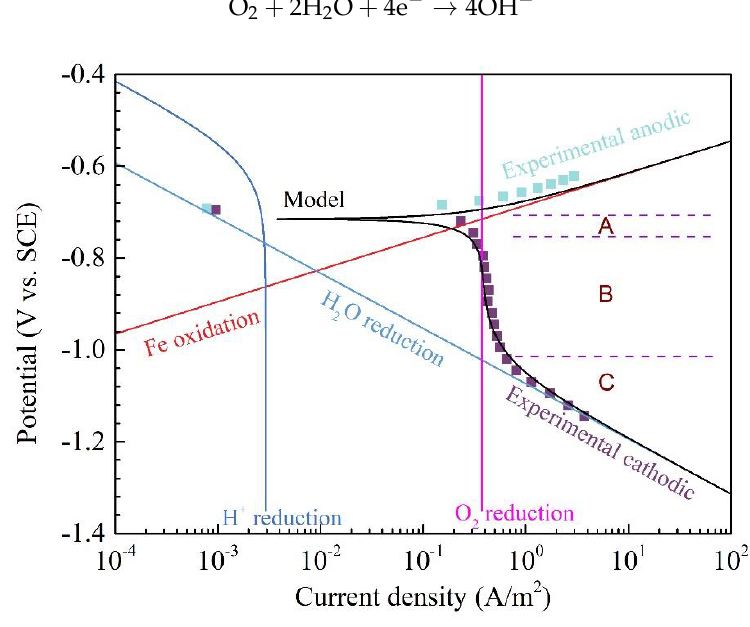
Figure 2. The polarization curves and its modeling results of Q345R steel in 1 wt.% NaCl solution containing 4.16 mg/L oxygen, with pH 6.0 at 30 °C. Square: experimental data. Solid line: modeling result.